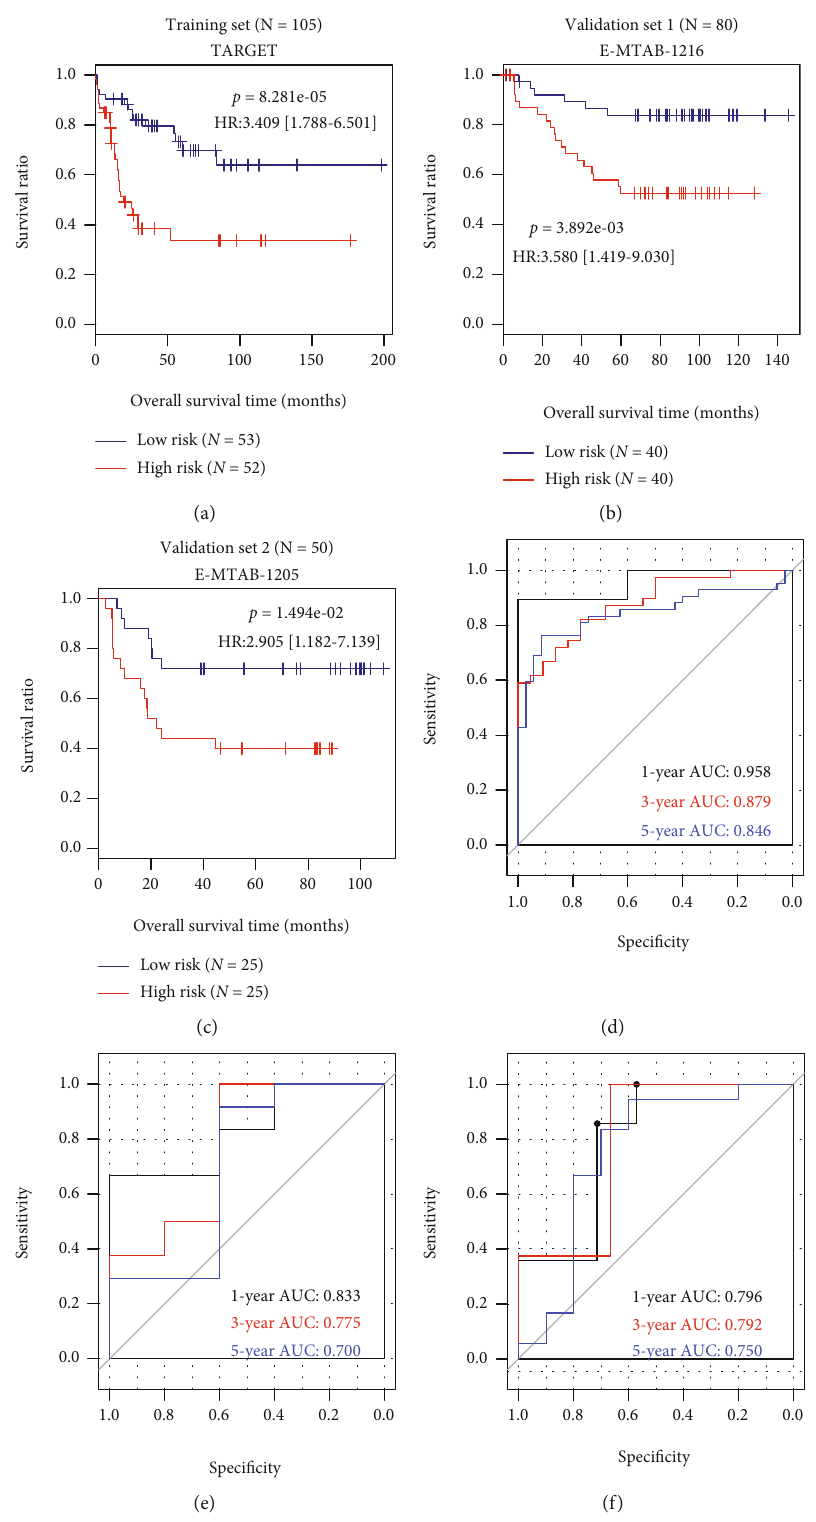
Figure 5: The prognostic performance of the risk score model established by the seven-lncRNA-mRNA signature genes. (a) Kaplan-Meier survival curve of the training dataset, TARGET; (b) Kaplan-Meier survival curve of validation dataset 1, E-MTAB-1216; (c) Kaplan-Meier survival curve of validation dataset 2, E-MTAB-1205; (d) ROC of the training dataset, TARGET; (e) ROC curve of validation dataset 1, E- MTAB-1216; (f) ROC curve of validation dataset 2, E-MTAB-1205. HR: hazard ratio; ROC: receiver operator characteristic curve; AUC: area under the ROC